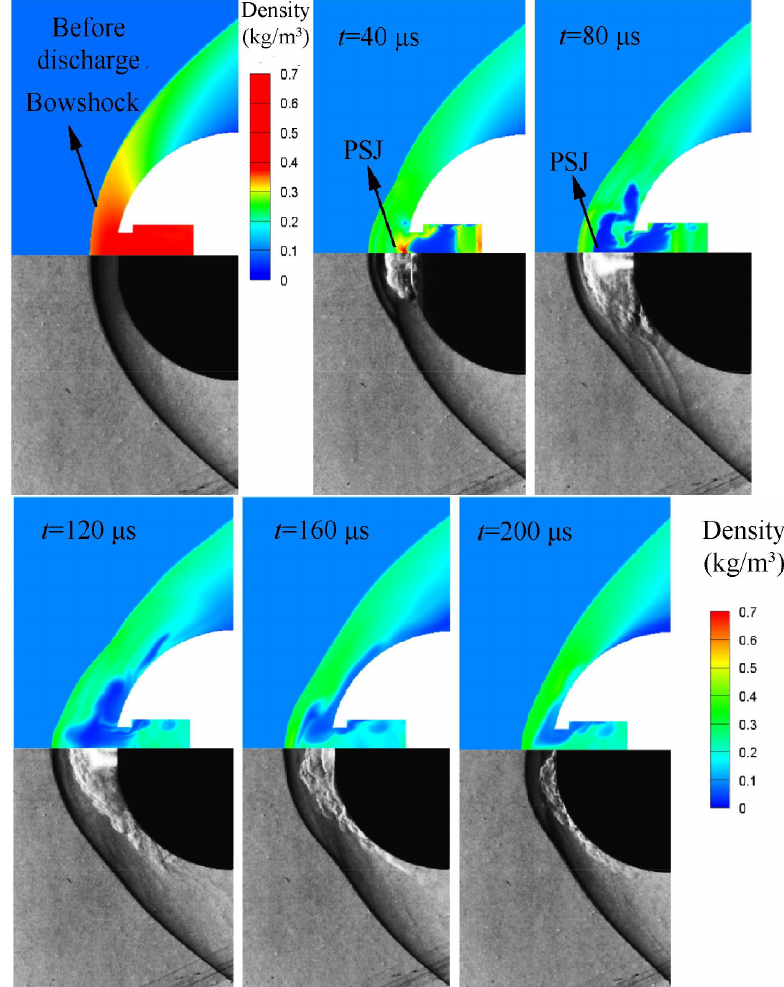
Figure 31. Comparison of the experimental and numerical results. Adapted from